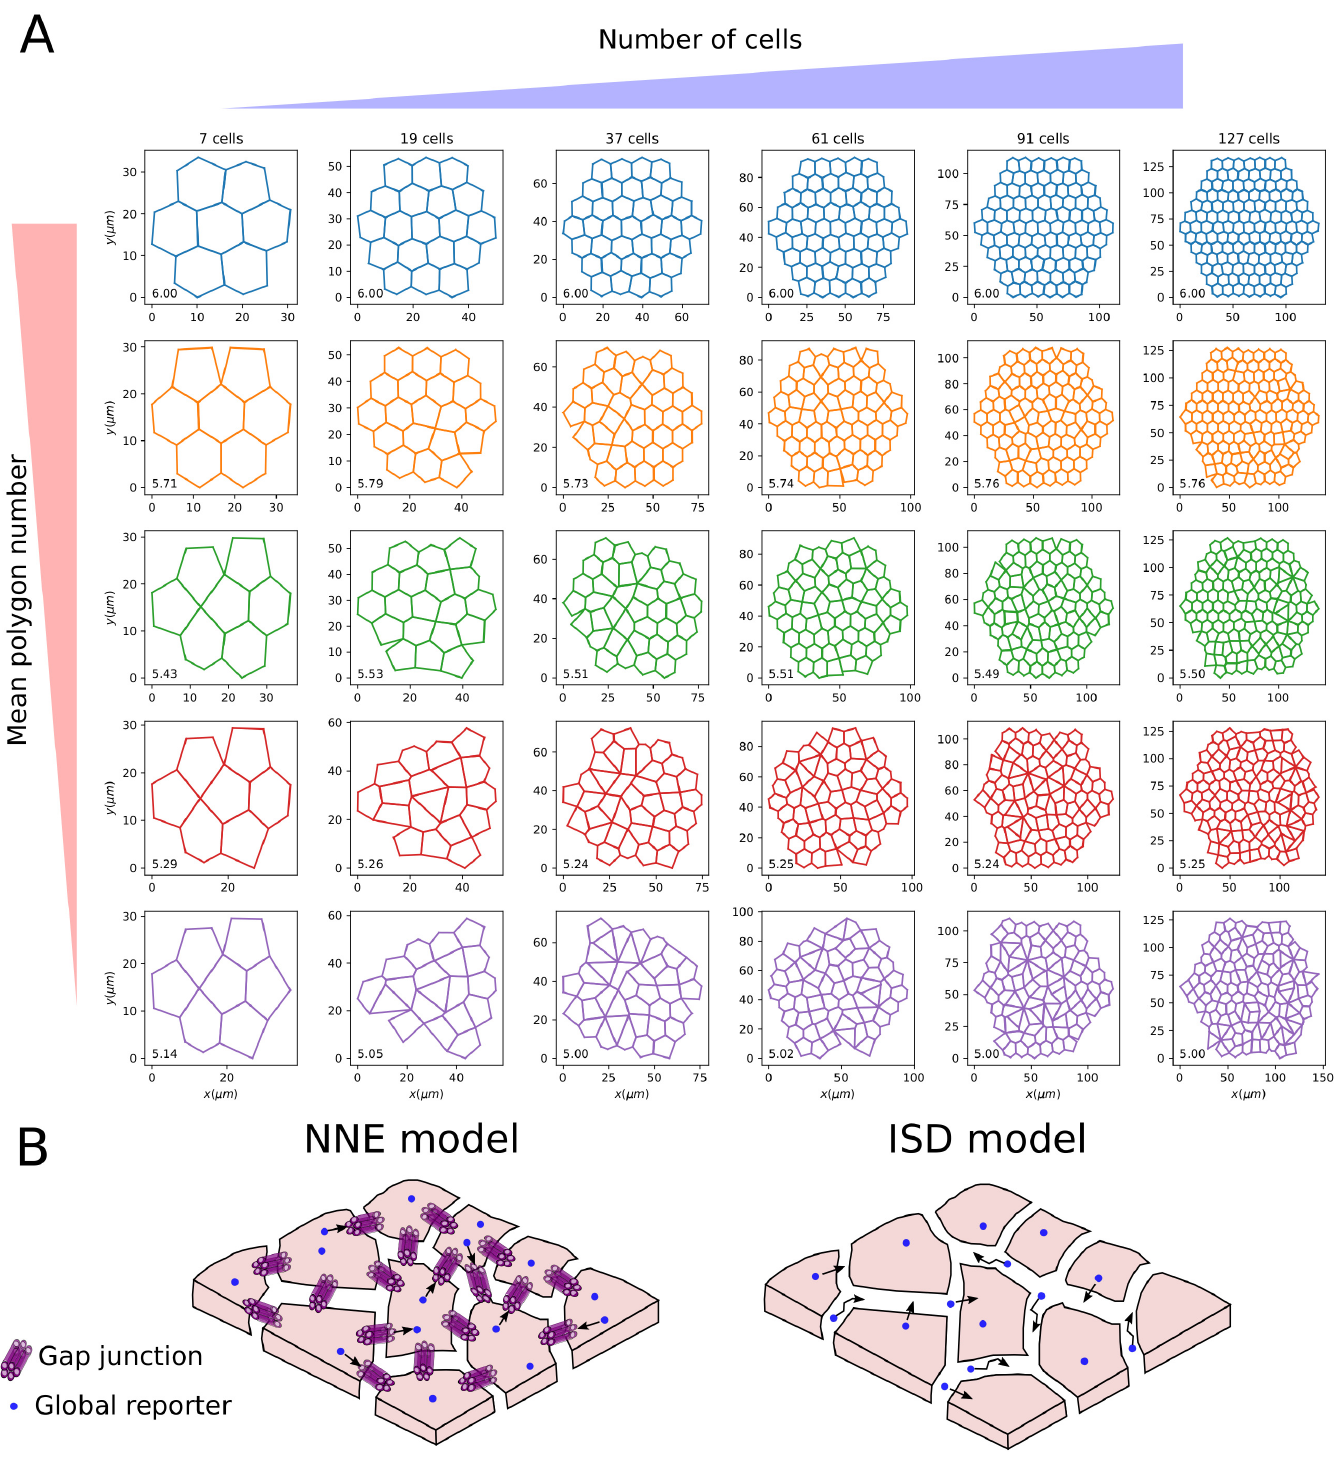
Fig 2. Generation of 2-dimensional epithelial sheets and intercellular communication modes. A: Examples of the 2D configurations of cells we generated with increasing cell numbers (from left to right) and decreasing mean polygon number (from top to bottom). The value of the mean polygon number is reported in the bottom left of each configuration. B: Scheme of the communication models studied in the present work: the Nearest Neighbour Exchange (NNE) model (left panel), where a global reporter (blue circle) is exchanged between nearest neighbour cells via, e.g., gap junctions; and an Intercellular Space Diffusion (ISD) model, in which the global reporter is secreted by cells and diffuses in the lateral intercellular space, thus allowing communication between non-nearest neighbours.